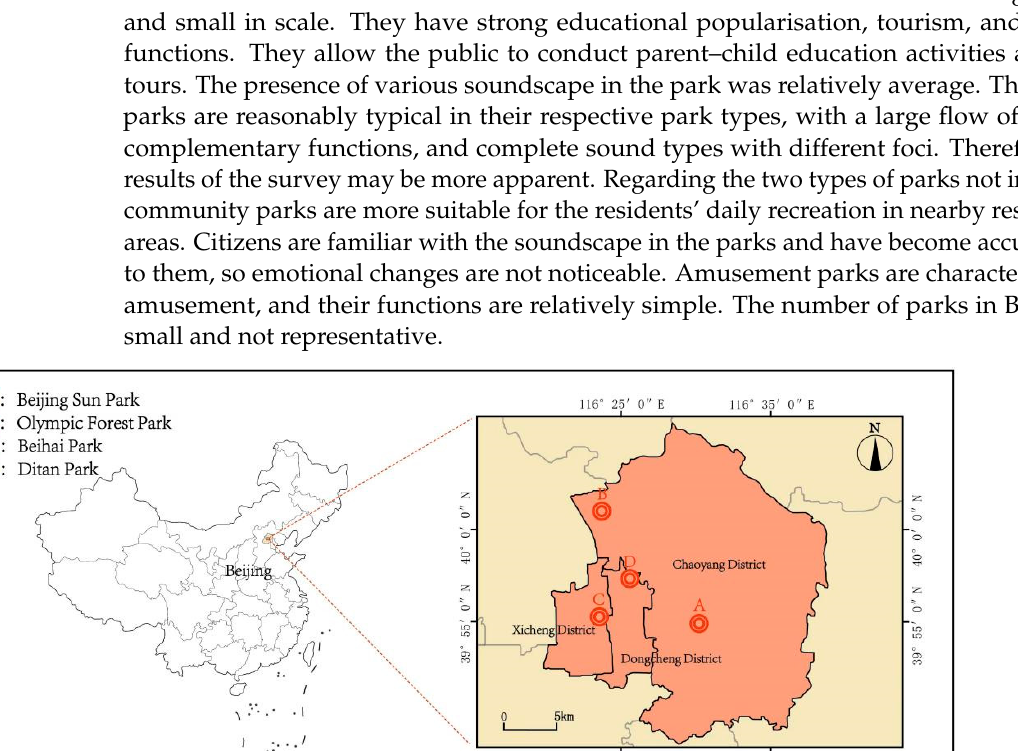
Table 1. Urban parks in Beijing.